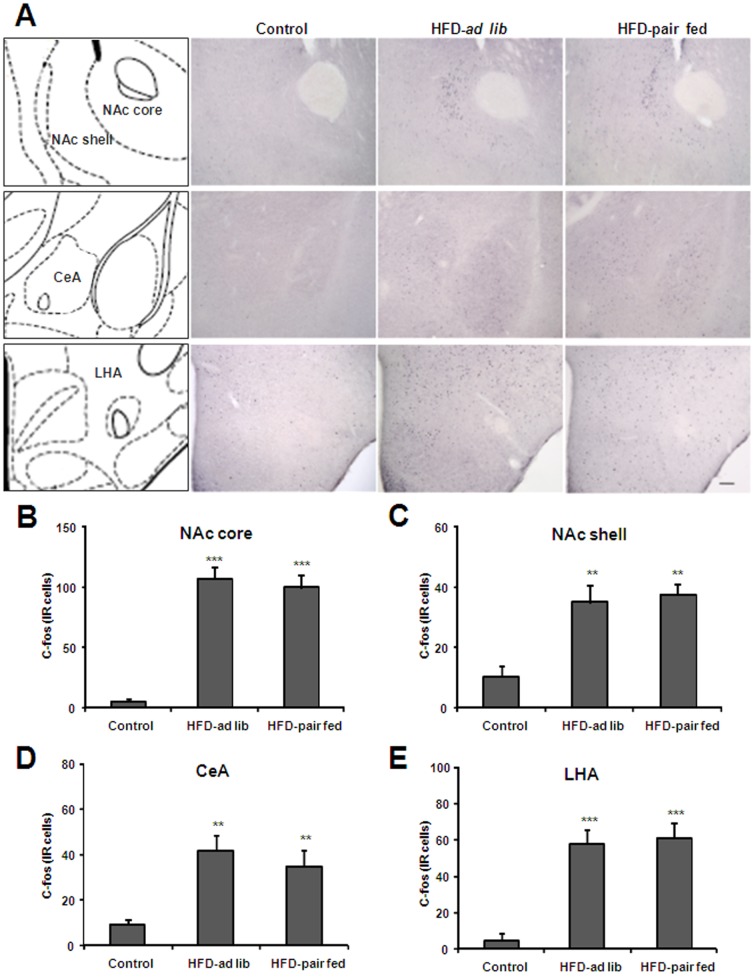
Acute HFD activates c-Fos in specific nucleus of mesolimbic pathway.Panel A shows a schematic diagram of the brain regions under study in a coronal section of the mouse brain (left column) and representative microphotographs of c-Fos immuno-staining of control, HFD-ad lib and HFD-pair-fed groups. Upper, middle and bottom line of images show the NAc (core and shell), the CeA and the LHA, respectively. Scale bar: 100 µm. Panels B-E show quantitative analysis of c-Fos staining in the NAc core (B), NAc shell (C), CeA (D) and LHA (E). Histograms depict the total number of c-Fos-IR neurons, expressed as cells per coronal section, for each experimental group. Values are the mean±SEM. **, p<0.01 vs. control group. ***, p<0.001 vs. control group.